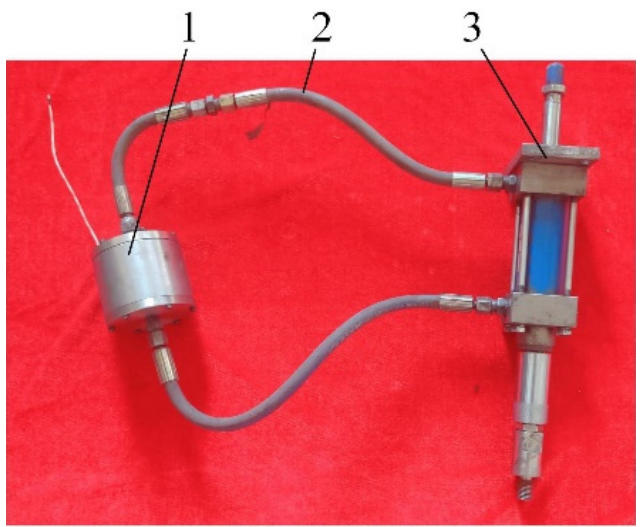
Figure 21. Comparison of the initial and optimal performance indicators: ( a ) pressure drop Δ p , ( b ) power consumption P w .